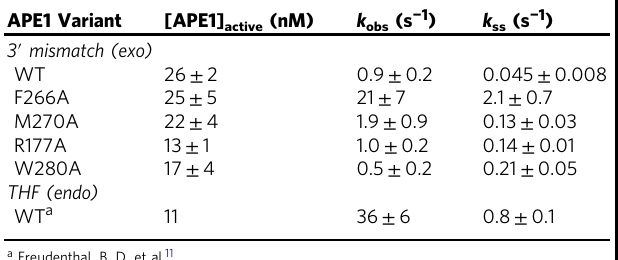
Table 2 Pre-steady-state kinetic parameters of the WT and mutant APE1 proteins APE1